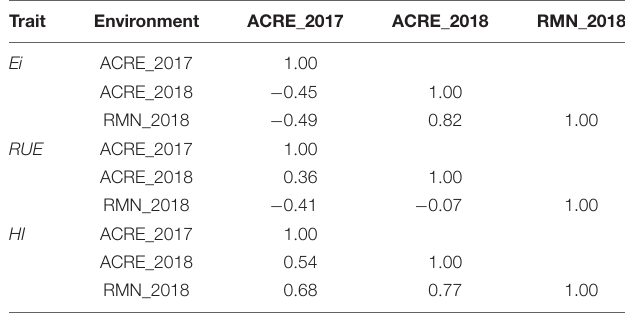
TABLE 4 | Trait stability assessed through the Kendall additive–genetic correlation between the same traits evaluated in different environments for light interception efficiency ( Ei ), radiation use efficiency ( RUE ), and harvest index ( HI ) in a maturity-controlled panel of soybean.